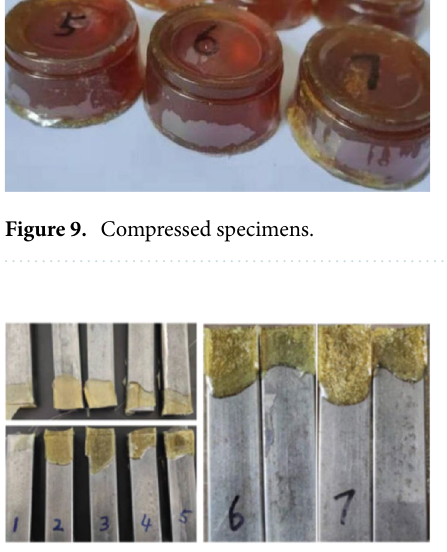
Figure 10. Adhesion test sample after tensile testing.